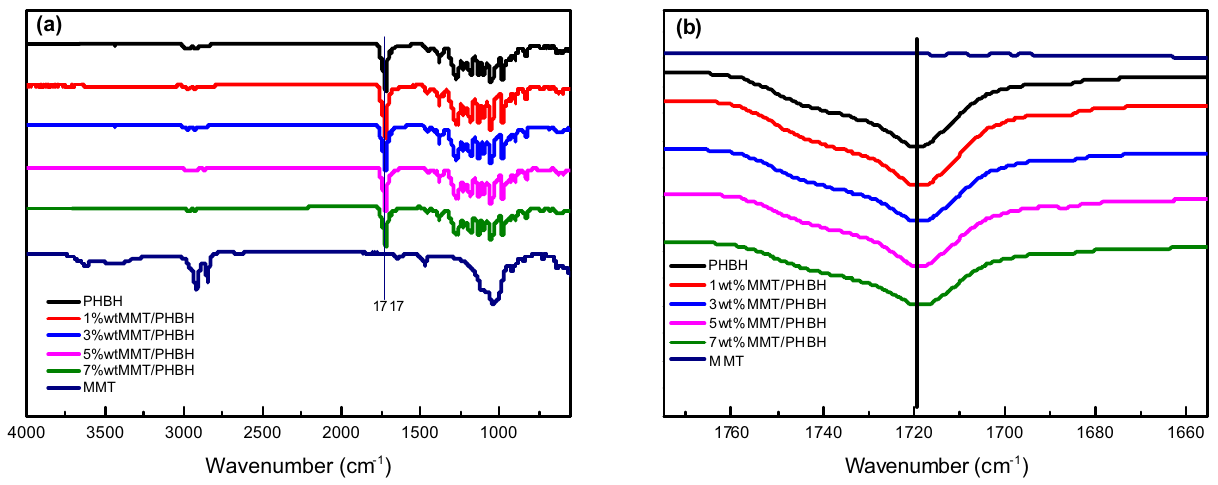
Figure 1: ( a ) FTIR spectra of PHBH, MMT, and MMT/PHBH biocomposites; ( b ) the local magni fi cation curve of FTIR